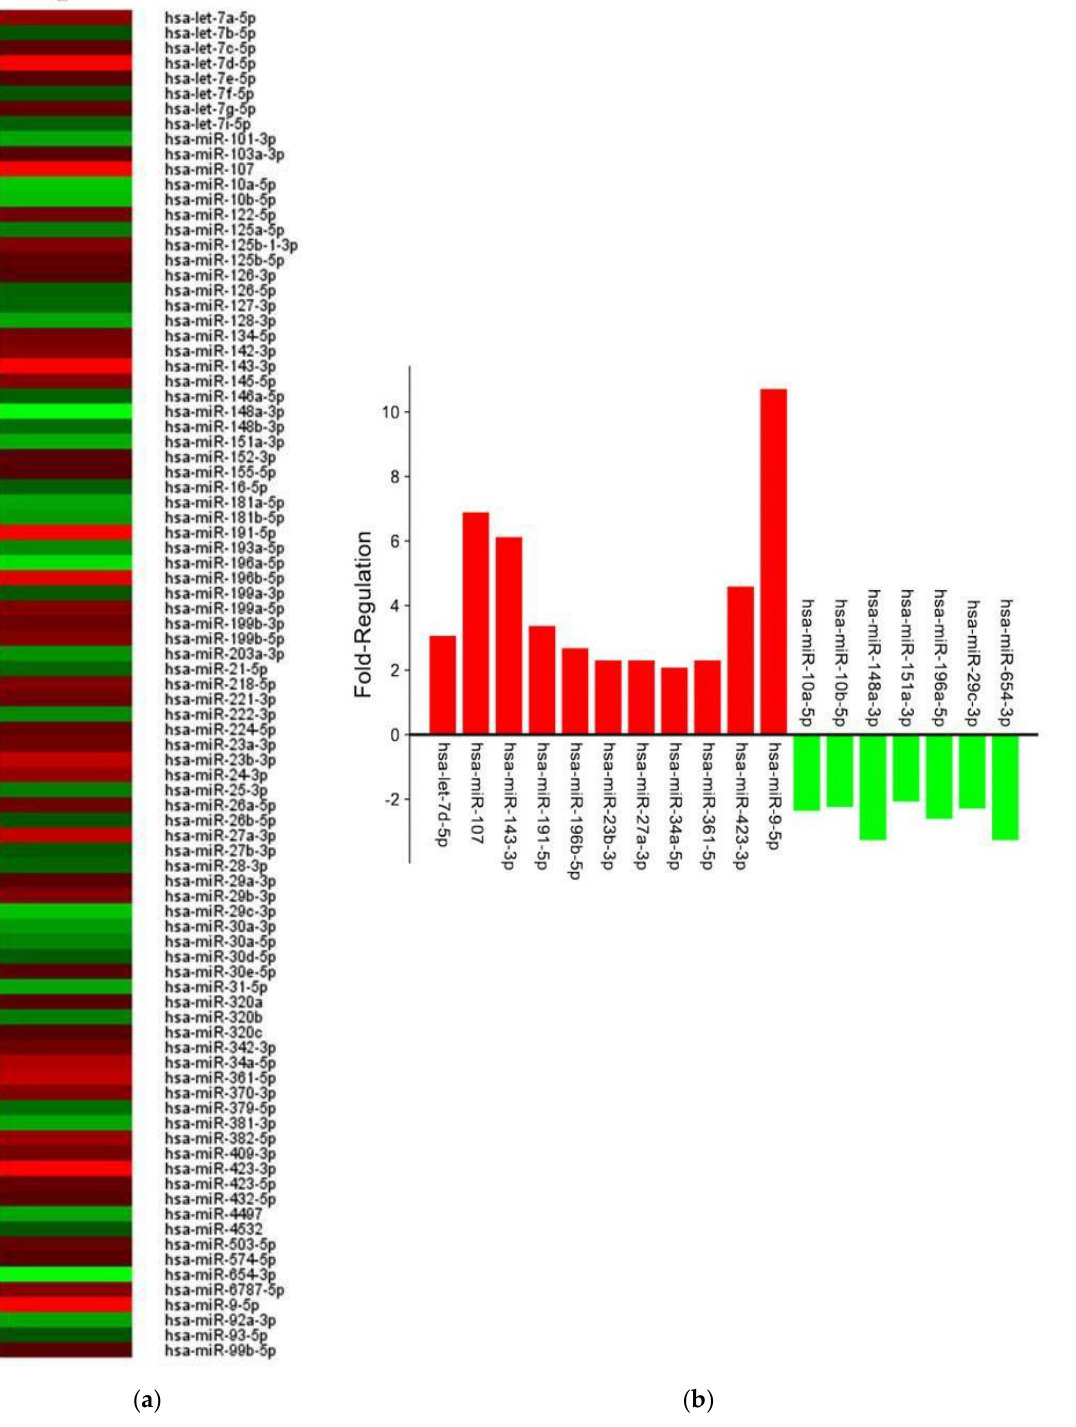
Figure 6. sEV-miRNA sequencing of HUVECs treated with DFO-sEVs. ( a ) Fold regulation of 89 identified miRNAs (upregulation cut-off > 2; downregulation cut-off < − 2). ( b ) Histogram with 11 upregulated and 7 downregulated miRNAs.